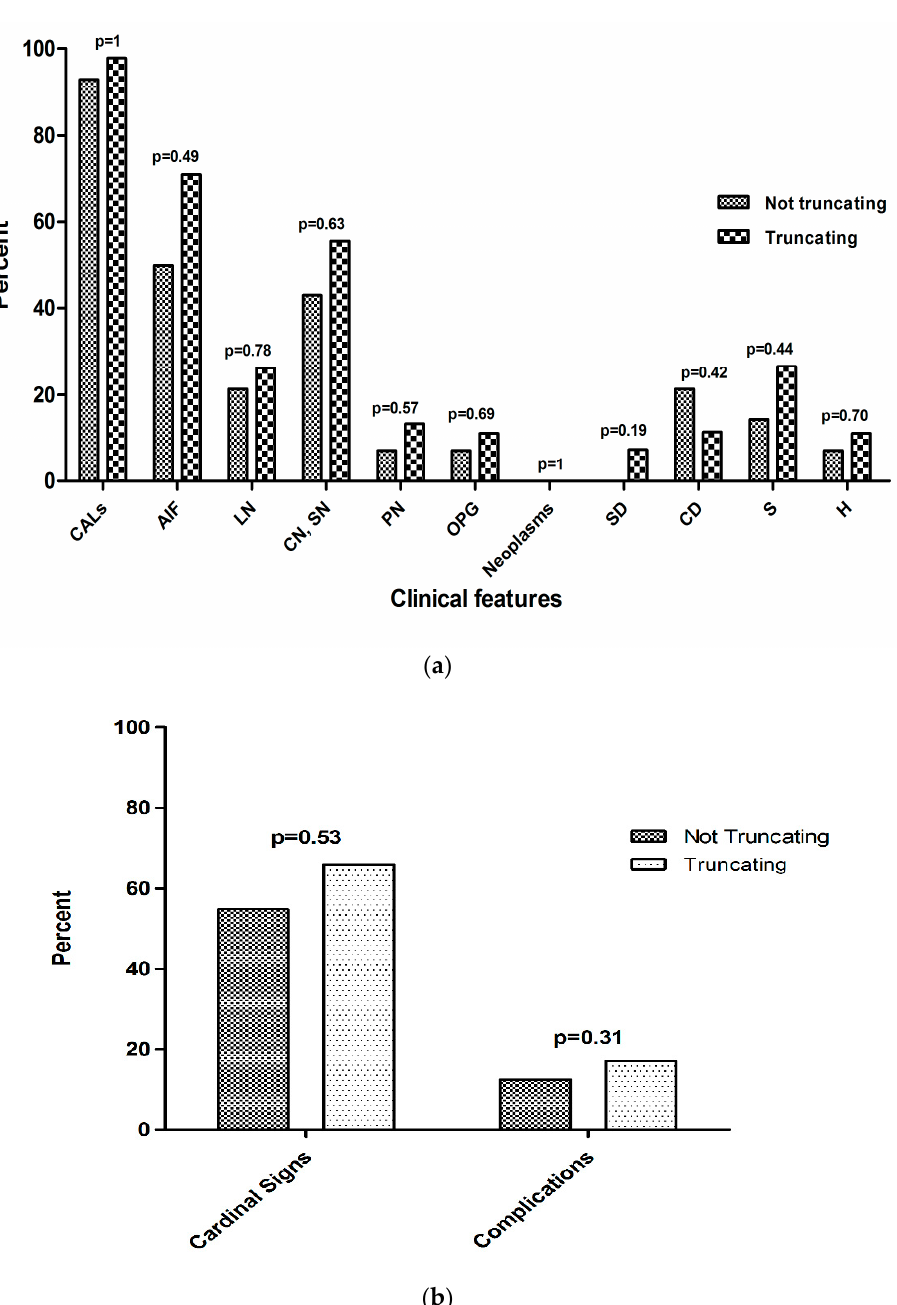
Figure 2. ( a ) Clinical features and ( b) aggregation of cardinal signs and complications in patients with truncating and non-truncating mutations. CALs: café-au-lait patches; AIF: axillary or groin freckling; LN: Lisch nodules; CN/SN: cutaneous/subcutaneous; PN: plexiform neurofibromas; OPG: optic pathway glioma; SD: sphenoid wing dysplasia; CD: cognitive deficit; S: scoliosis; H: hypertension.